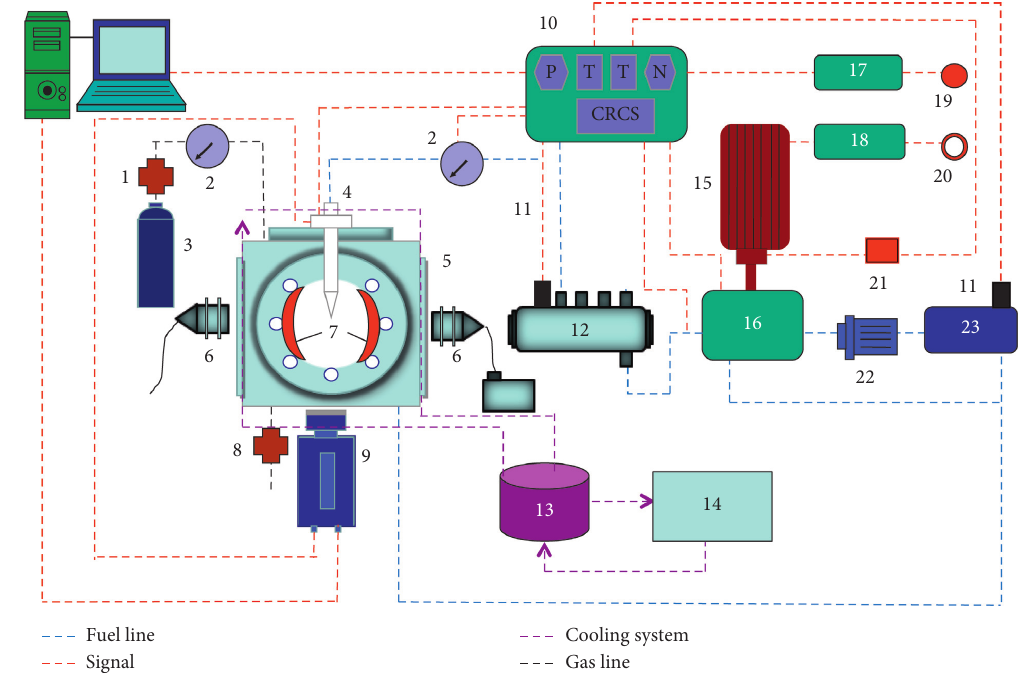
Figure 1: Schematic of Mie scatter (1, pressure reducing valve; 2, pressure meter; 3, nitrogen gas; 4, injector; 5, constant volume; 6, LED light source; 7, heating panels; 8, exhaust valve; 9, CCD camera; 10, high-pressure common rail system; 11, thermoelement; 12, common rail; 13, cooling water tank; 14, condenser; 15, electric motor; 16, high-pressure fuel pump; 17, switchboard; 18, transducer; 19, sensor switch; 20, potentiometric control unit; 21, speed sensor; 22, fuel filter; 23, fuel tank). Table 1: Properties of experiment fuels.